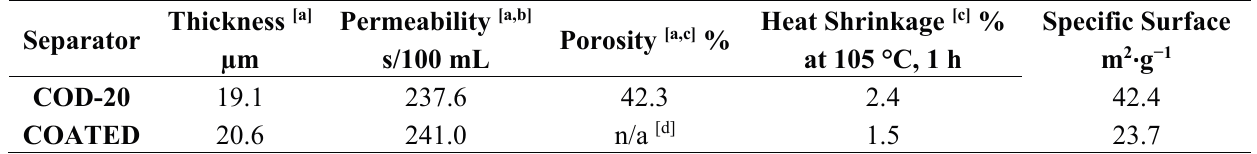
Table 3. Both separators and selected properties based on supplier